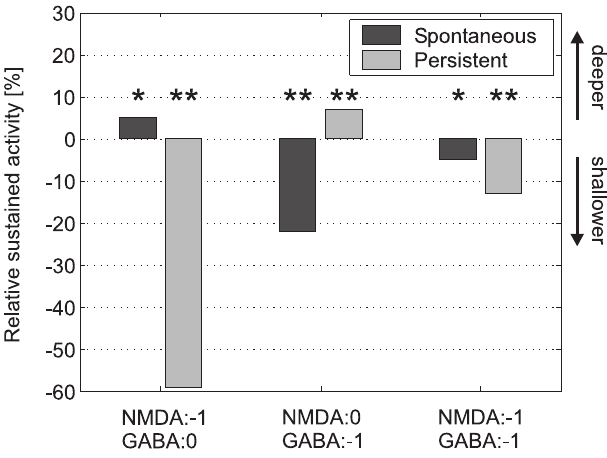
Figure 3. Stability of the Spontaneous and Persistent States We assessed how often in 100 trials the average activity during the last second (2–3 s) stayed above 10 Hz. The value shows how often it stayed more in the respective state than in the unmodulated reference state. A negative percentage means that the system was less stable than in the reference state. A modulation of the synapses shown as (cid:2) NMDA and (cid:2) GABA corresponds to a reduction of 4.5% and 9% in their efficacies, respectively. We assessed with the binomial distribution the statistical significance of the effects observed; ** p , 0.01 relative to the reference state, and * p , 0.02.